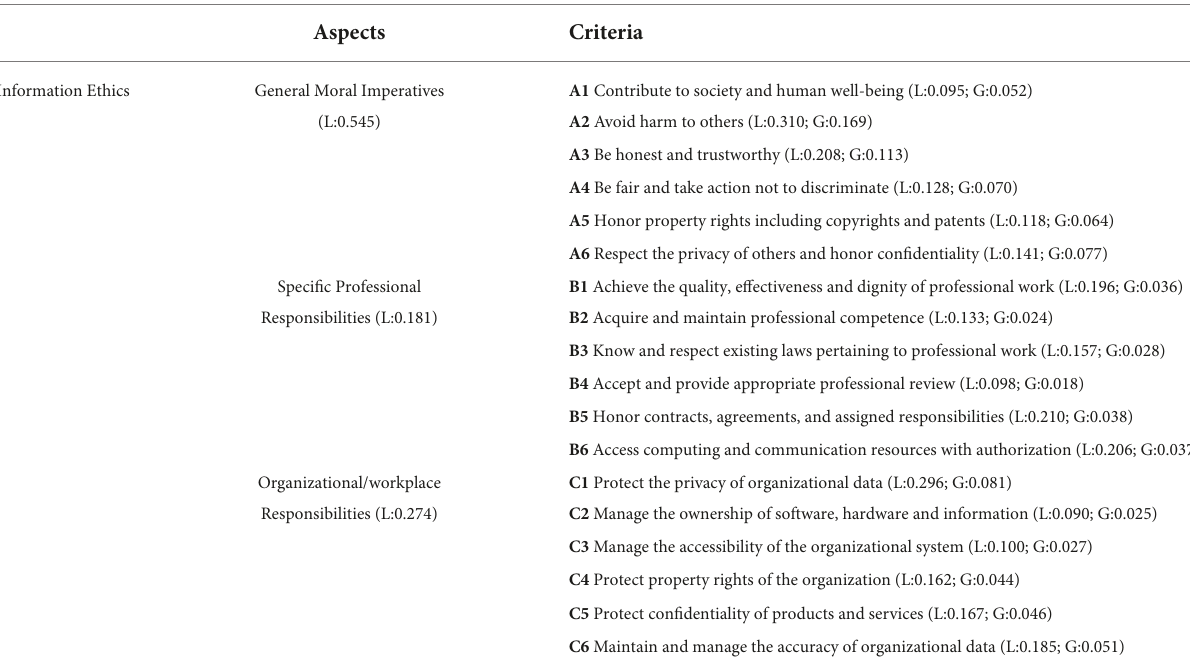
TABLE 13 Information technology experts’ local and global weights of all criteria of the